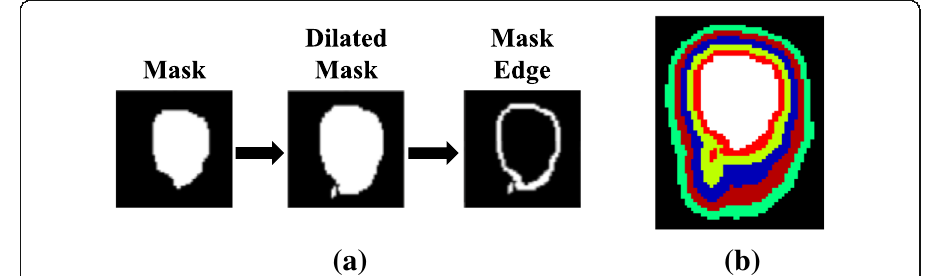
Fig. 2 The schematic 2D representation of the technique used to extract the voxel values around the edges of the simulated bladder. a represents the procedure for extracting the voxel values, while b shows a 2D representation of all the dilated 3D regions around the bladder (i.e. the white region) from 2 voxels to 10 voxels with a step size of 2